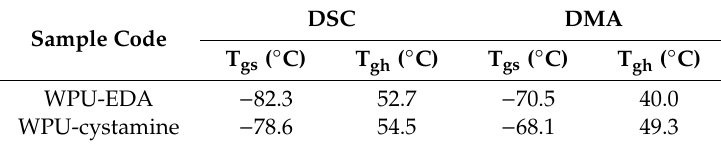
Figure 4. DSC thermograms of WPU films. Table 1. Glass transition temperatures of WPU-EDA and WPU-cystamine.